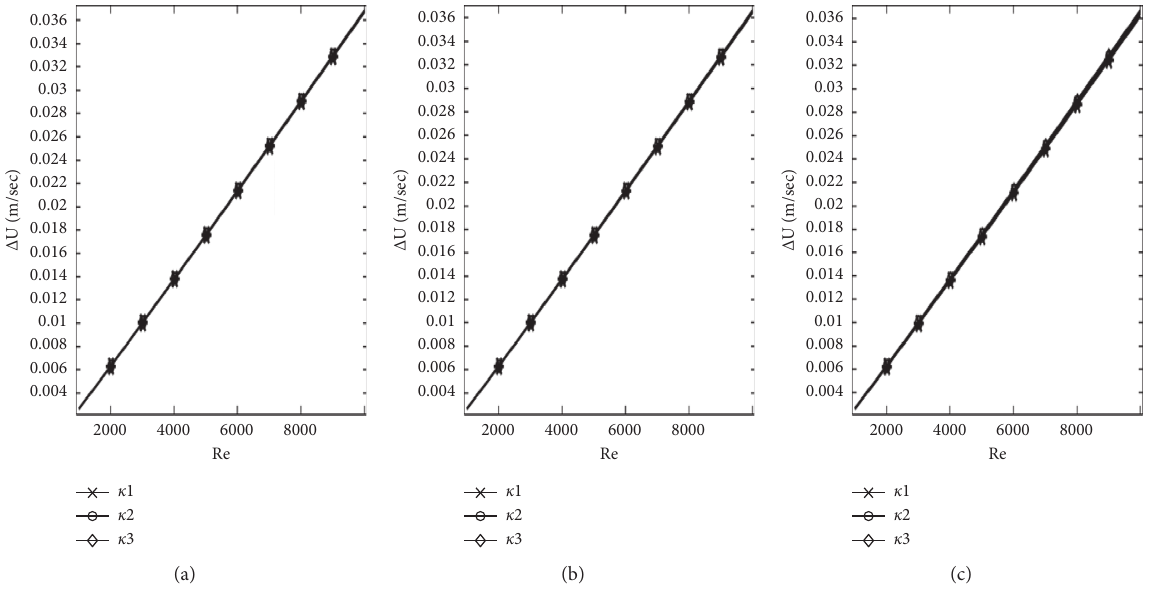
Figure 9: Rise of the velocity magnitude ( m/sec ) from inlet to the surface of the circular cylinder for all resistance coefficients: (a) θ � π /6; (b) θ � π /4; (c) θ � π